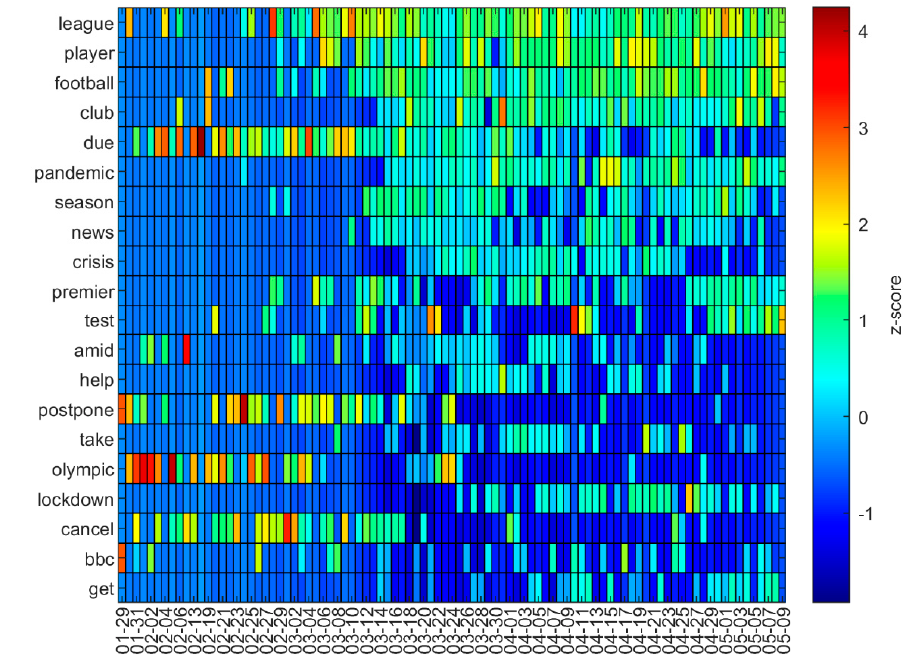
Figure 3. Dynamics of the 20 most repeated words during the study period .